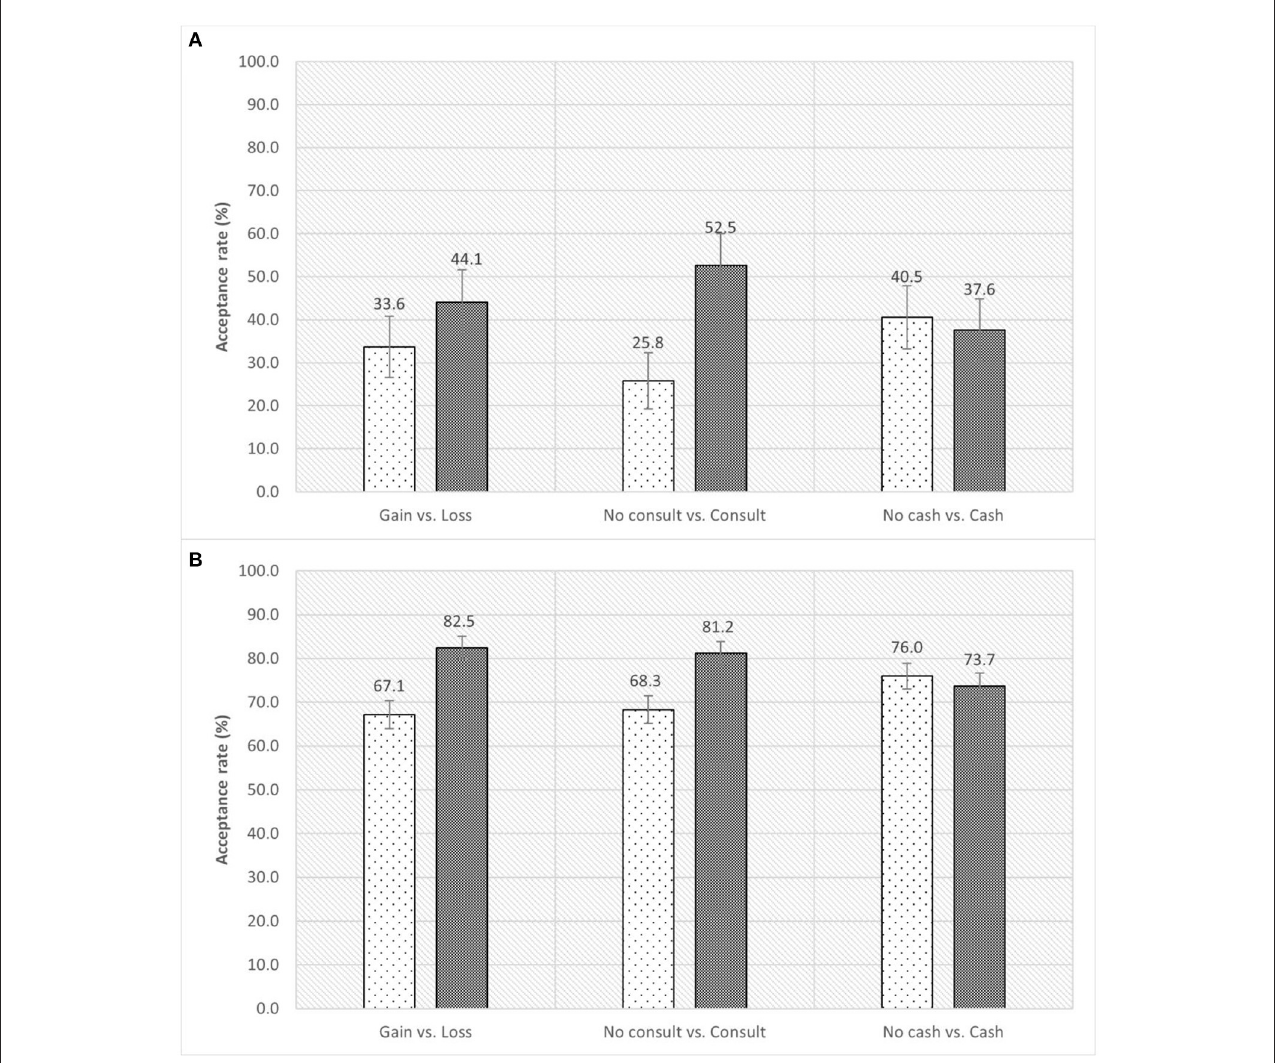
FIGURE1 Vaccine acceptance rate for participants under different strategies. (A) Refers to the vaccine acceptance rate for those who did not receive COVID-19 vaccine. (B) Refers to the willingness to accept the vaccine earlier than actually did for those who received at least one dose of COVID-19 vaccine. The error bar refers to 95% confidence interval of the acceptance